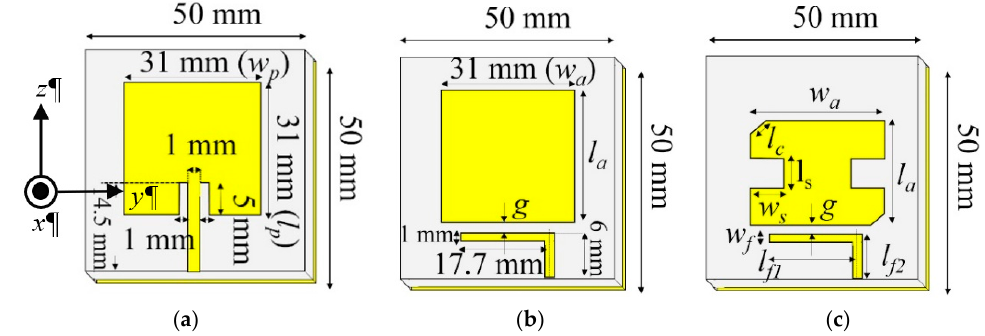
Figure 1. Geometry of the direct-fed (D-fed) antenna and the proximity-fed (P-fed) antennas. ( a ) D-fed Rect-MSA; ( b ) P-fed Rect-MSA; ( c ) proposed P-fed I-shape MSA.